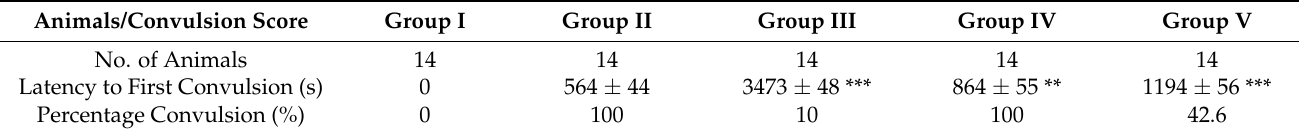
Table 1. Zingerone and sodium valproate effects on seizure severity and latency to onset of SE in LiCl-and-pilocarpine- induced epilepsy in